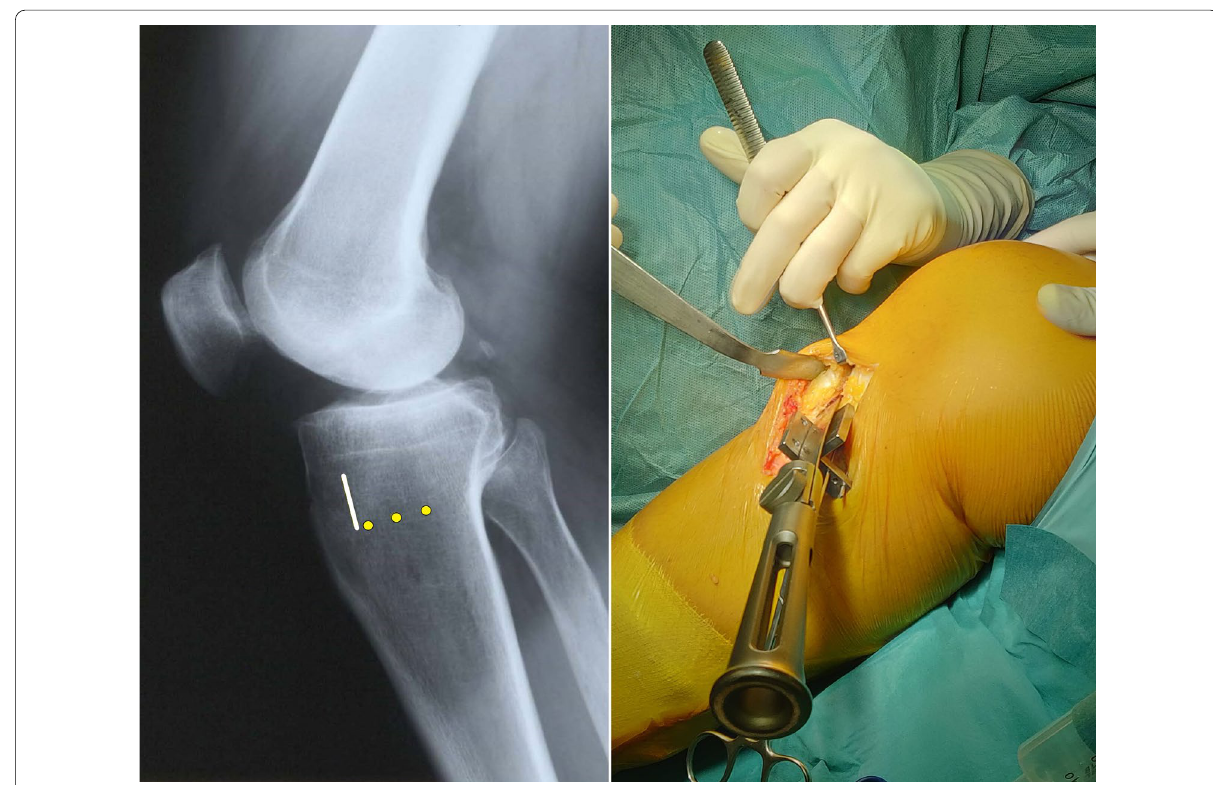
Fig. 4 On the left, a graphical representation of the three guide wires (yellow dots) and the first coronal osteotomy (vertical white line), on a lateral X-ray view of a right knee. On the right, the intraoperative findings of the first coronal osteotomy completed with a sharp thin 2-cm large osteotome, in a right tibia, with the assistance of the self-made cutting